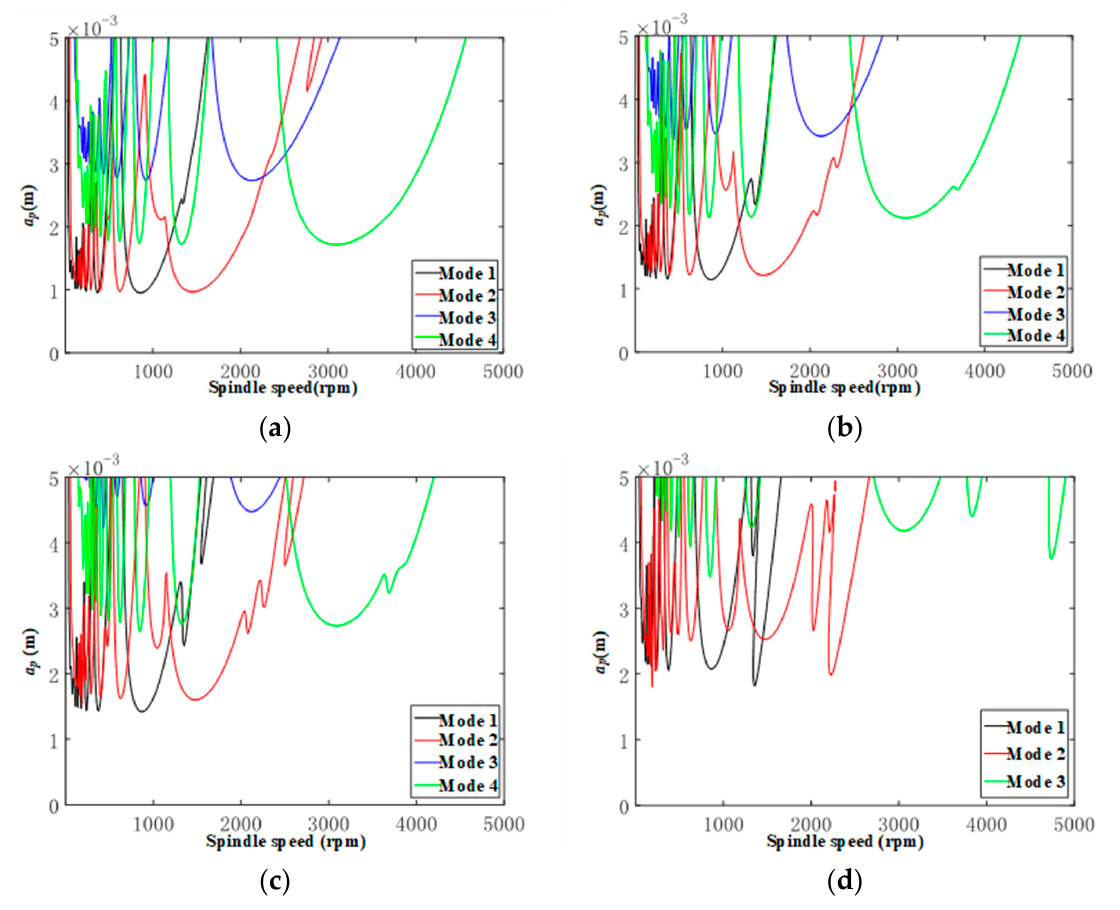
Figure 16. Stable lobe of TriMule with different radial cutting depths at Position 1. ( a ) d = 0.8. ( b ) d = 0.6. ( c ) d = 0.4. ( d ) d = 0.2.